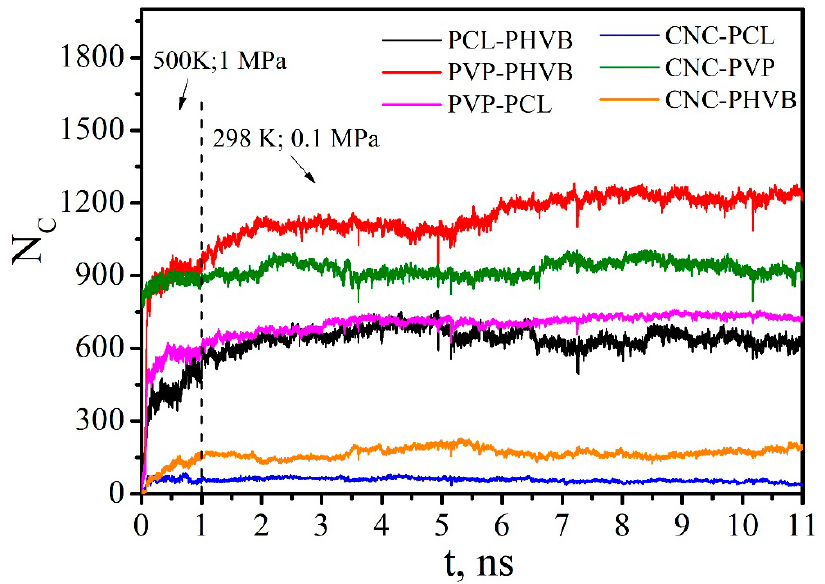
Figure 23. The number of close contacts between atoms of the components within a distance of 0.5 nm.